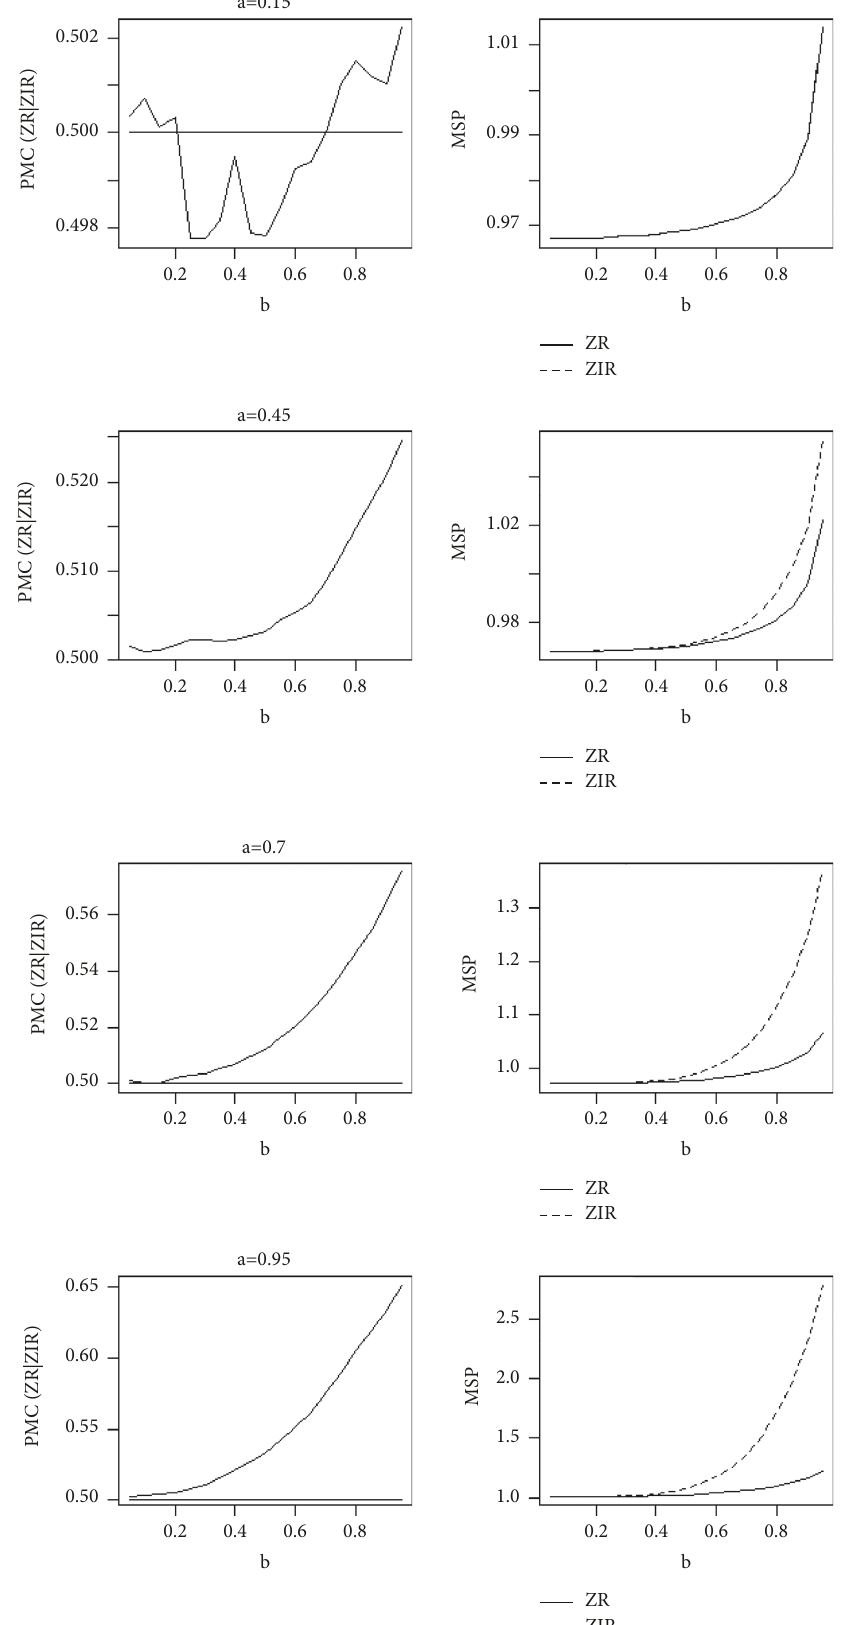
Figure 5: Comparison between 􏽢 Z IR and 􏽢 Z IR with normal errors for some fixed b and all a